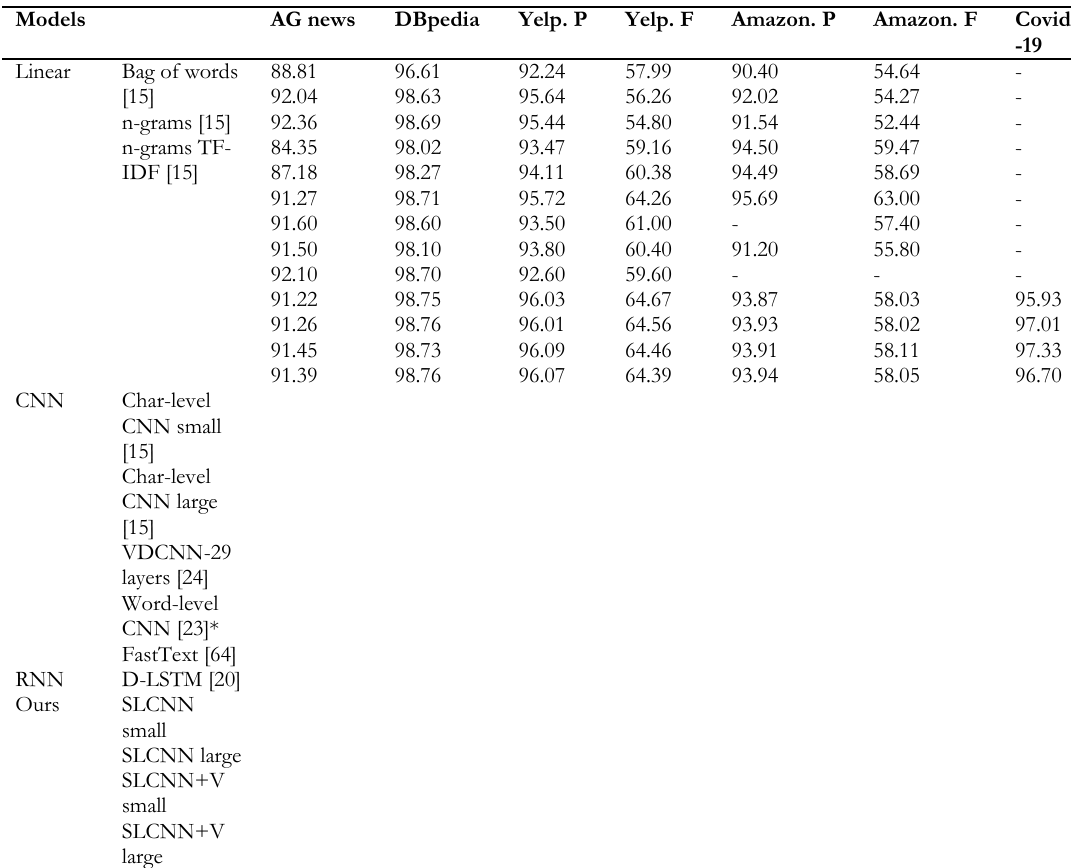
Table 4. Test accuracy (%) of all the models on the datasets. Results marked with * are reported in [11] and others are reprinted from the